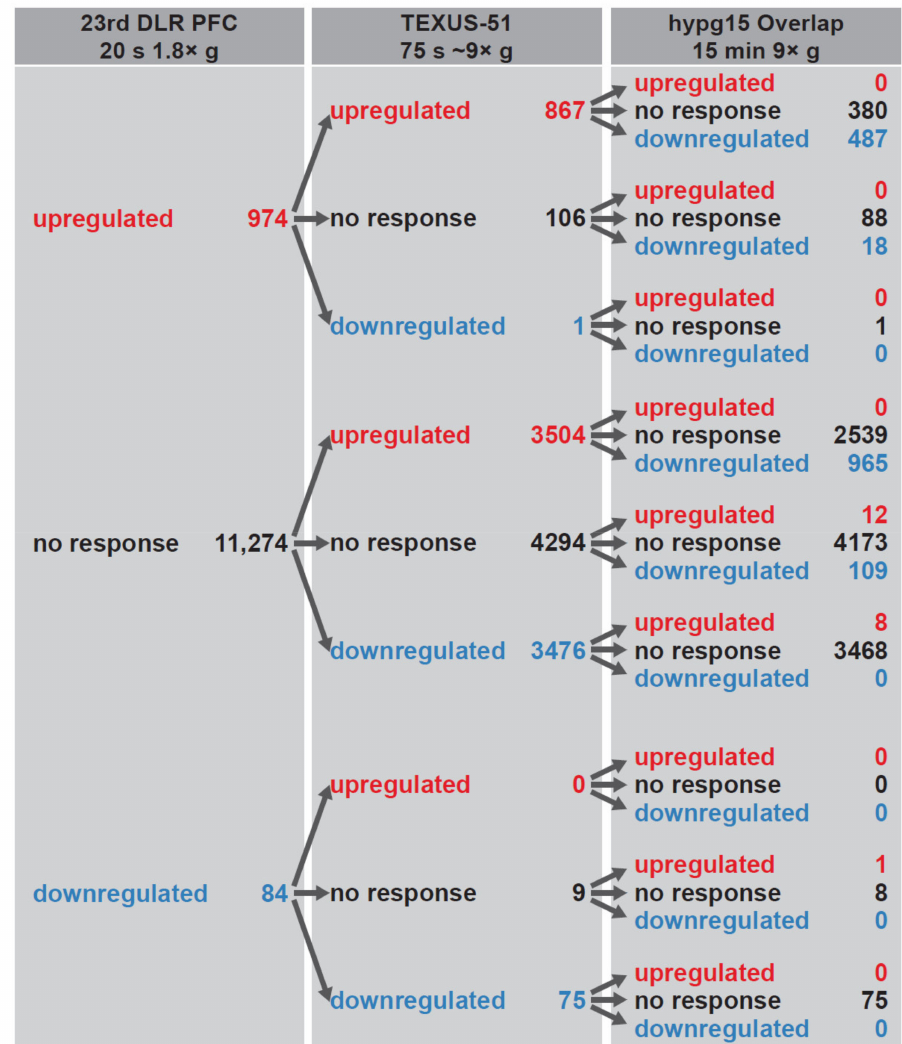
Figure 7. Corresponding differential expression between the 20 s 1.8 × g 23rd DLR PFC hypg vs. 1 × g IF data set, the 75 s ~9 × g TEXUS-51 hypg-1gGC data set, and the 15 min hypg15 vs. Ctrl data set. For the first data set, genes were separated into those that were significantly upregulated, downregulated, and not differentially expressed. Then, the genes in every group were split into those that were differentially upregulated, downregulated, or not differentially expressed in the TEXUS-51 comparison, resulting in 9 categories. These 9 categories were consecutively split into 27 categories, depending on the behavior of the genes in the hypg15 vs. Ctrl microarray data